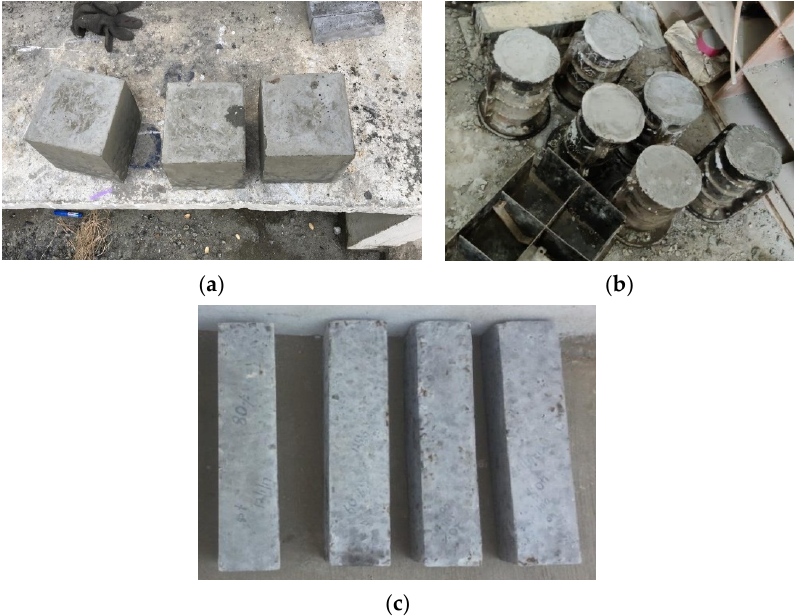
Figure 3. Test specimens ( a ) Cube specimens ( b ) Cylinder specimens ( c ) Flexure beam specimen.